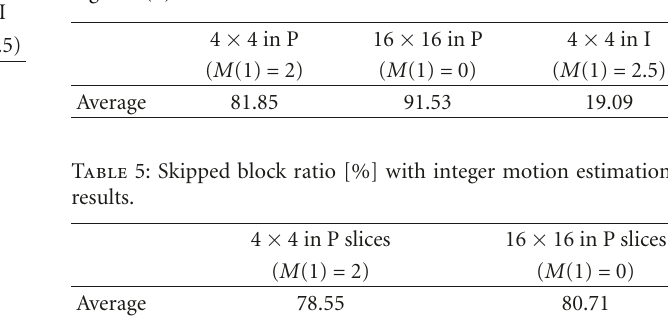
Table 3: Skipped block ratio [%]. Table 4: Skipped block ratio [%] with the new order shown in Figure 3(b).